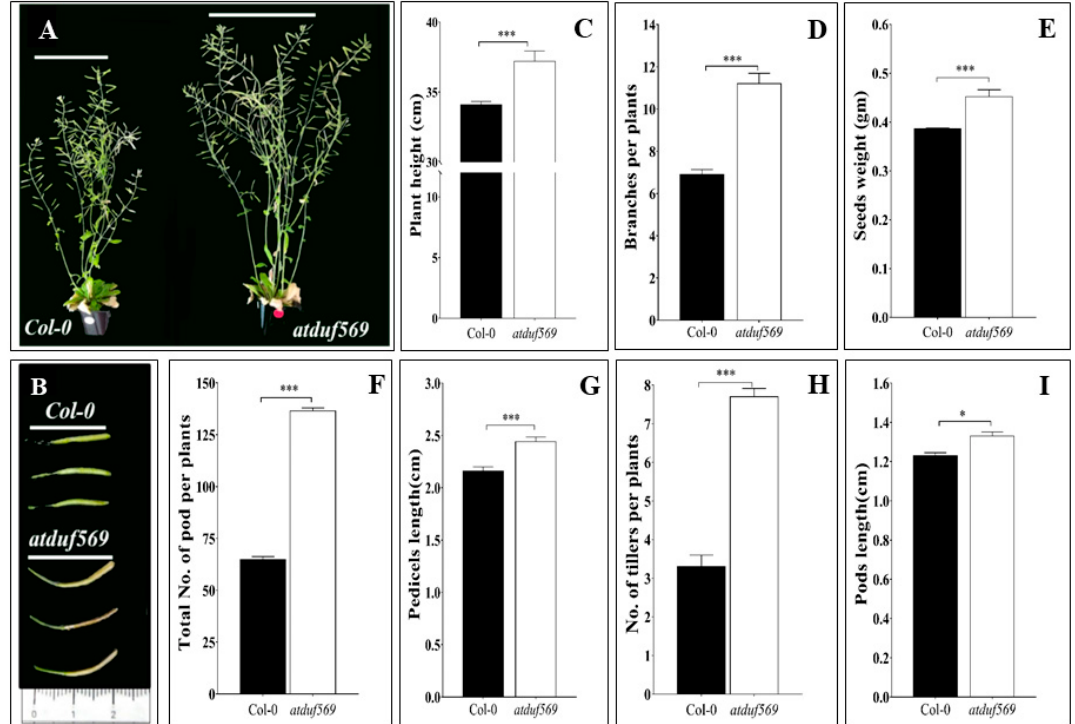
Figure 1. Phenotypic evaluation of the Arabidopsis atduf569 mutant and WT Col-0 plants. ( A ) Phenotypic appearance of plants at the silique stage. ( B ) Pod length in the two genotypes. ( C ) Plant height of 8-week-old plants. ( D ) The number of branches per plant. ( E ) Seed weight measured after the final seed harvest. ( F ) The total number of pods of 8-week-old plants. ( G ) Pedicel length recorded in 8-week-old plants. ( H ) Tiller number in the two genotypes. ( I ) Pod length measured at the 8-week stage. Data represent means of values obtained from experiments performed in triplicate. Error bars represent standard deviation. Means were analyzed for significant differences using Student’s t -test. Asterisks * indicate significant differences at 5% level of significance (*** p < 0.001, * p < 0.05).